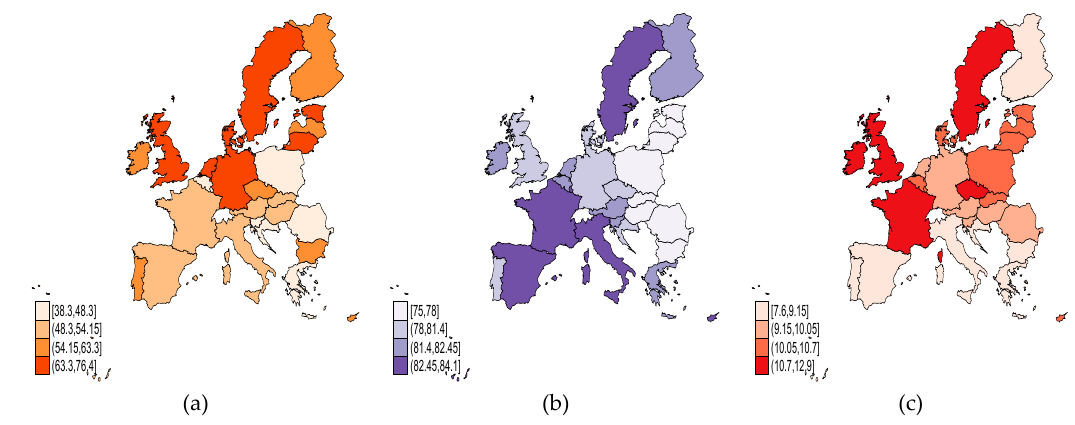
Figure 1. Aging representative indicators, European Union (EU)-28, 2017: ( a ) Employment rate, 55–64 years (ER_55_64) ; ( b ) life expectancy (LE) ; ( c ) birth rate ( BR). Source: Own process in Stata.